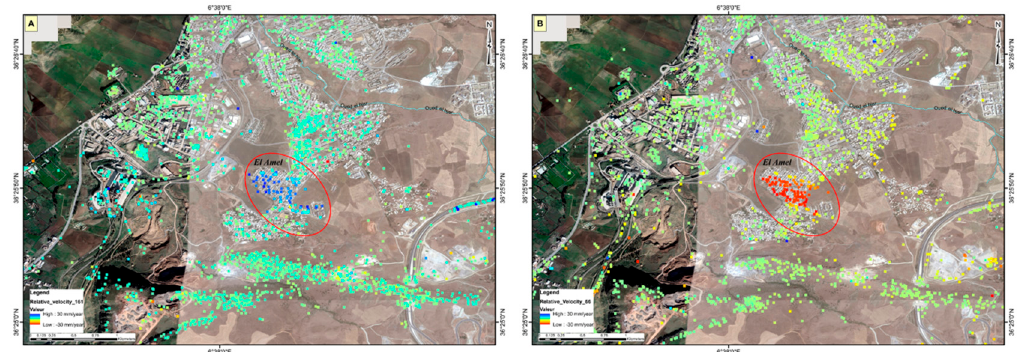
Figure 10. Deformation map of El-Amal; ( A ) ascending orbit number 161; ( B ) descending orbit number 66.